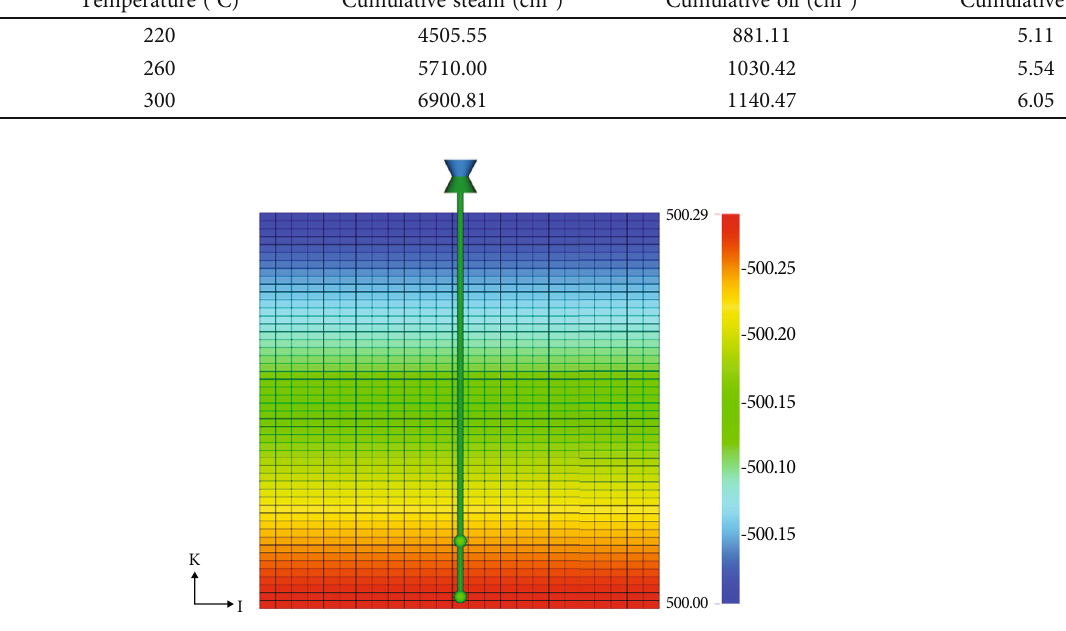
Figure 19: I - K view of the model. Table 4: Relevant parameters of the SAGD model. Table 5: Thermophysical parameters of the rock and fl uid in the SAGD numerical